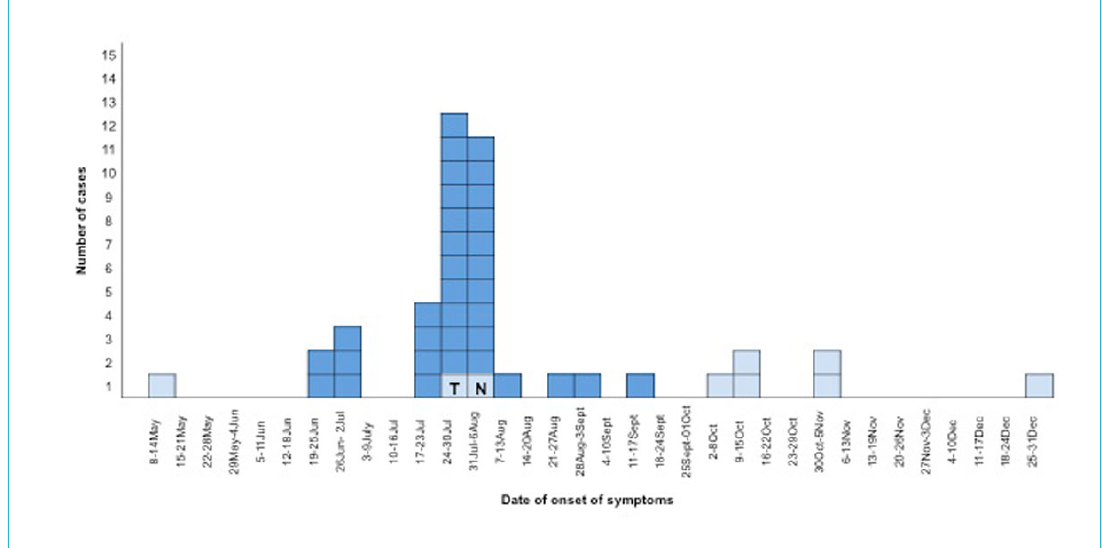
Figure 1: Number of confirmed Legionnaires’ disease cases by date of onset of symptoms, Geneva, Switzerland, May-December 2017. Dark blue squares: cases attributed to the outbreak. Light blue squares: cases not attributed to the outbreak. N: possible nosocomial case. T: travel- associated case.